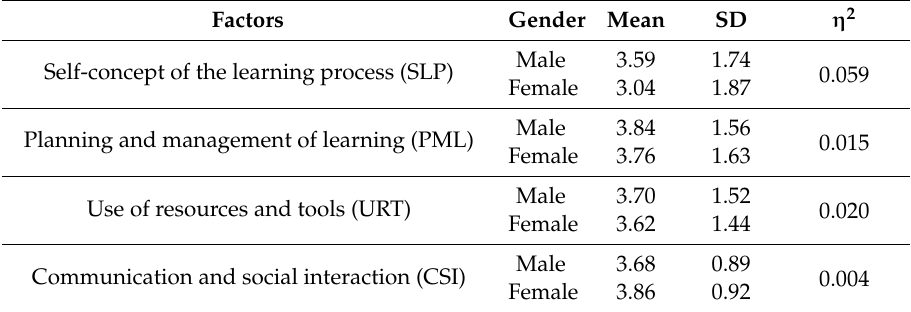
Table 1. Mean, standard deviation (SD) and Eta-squared ( η 2) obtained after administration of the socio-educational integration strategies questionnaire (SINQ).